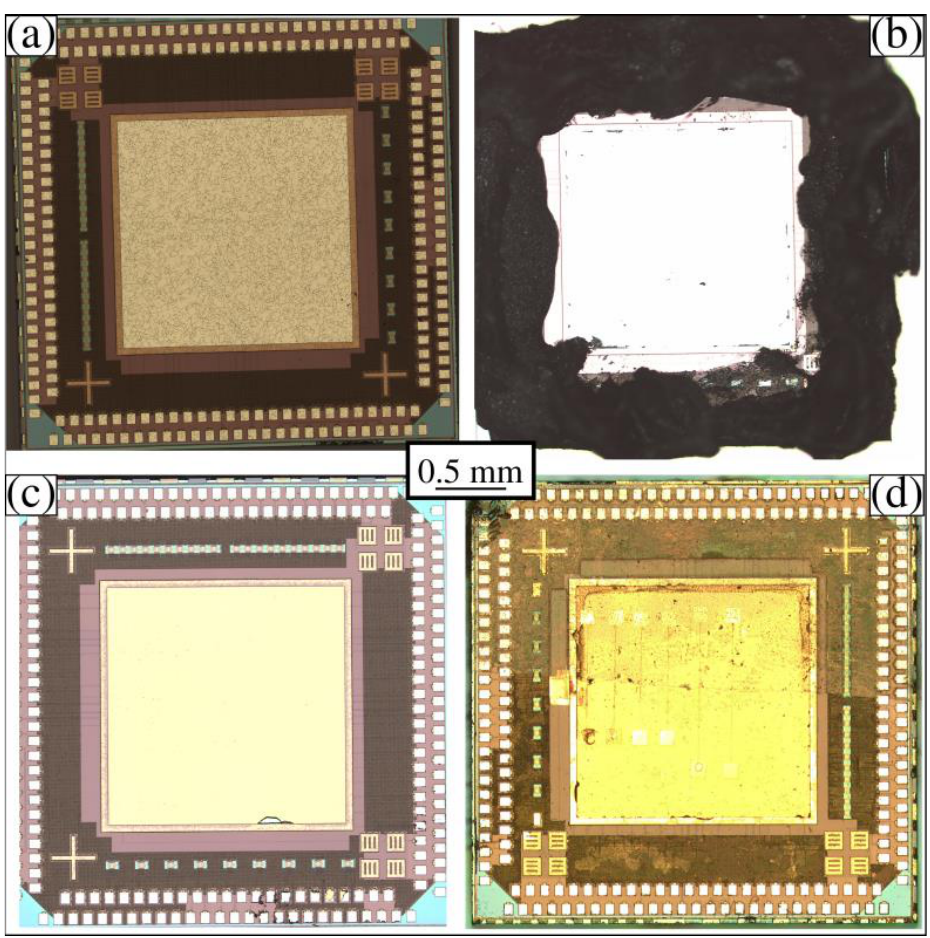
Figure 12. TSMC chip procedure. ( a ) Chip obtained from TSMC. ( b ) Chip with the outer bonding pads covered with carbon paint. ( c ) Chip after etching away the central aluminum bonding pad. ( d ) Graphene membrane suspended over multiple trench-well-tip features.